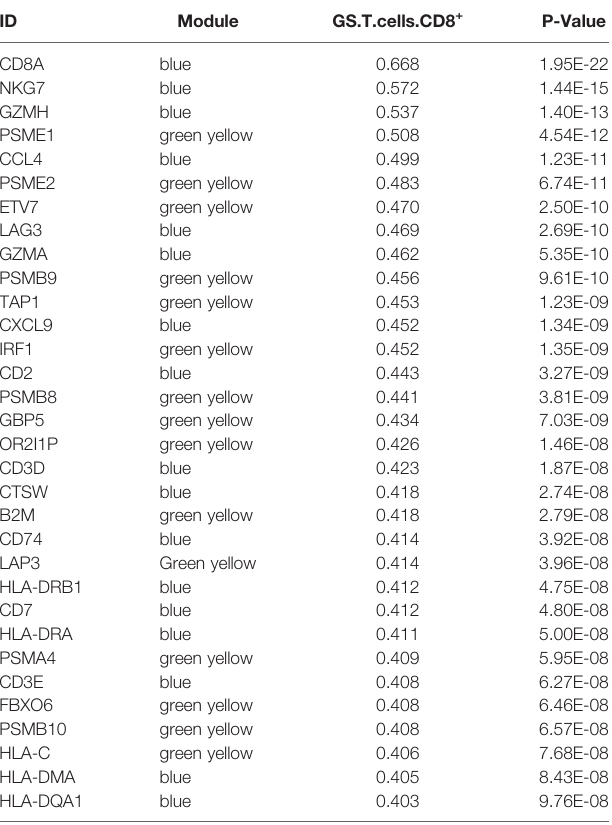
TABLE 1 | The Module and Gene signi fi cance for CD8 + T Cells related